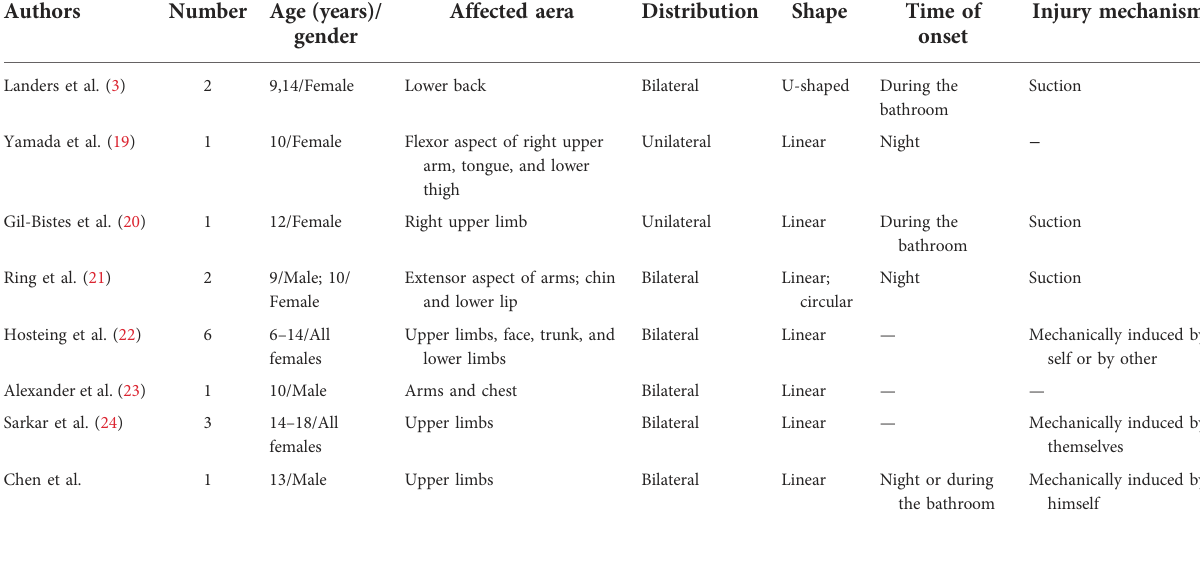
TABLE 1 Comparison of published cases with artefactual purpura.